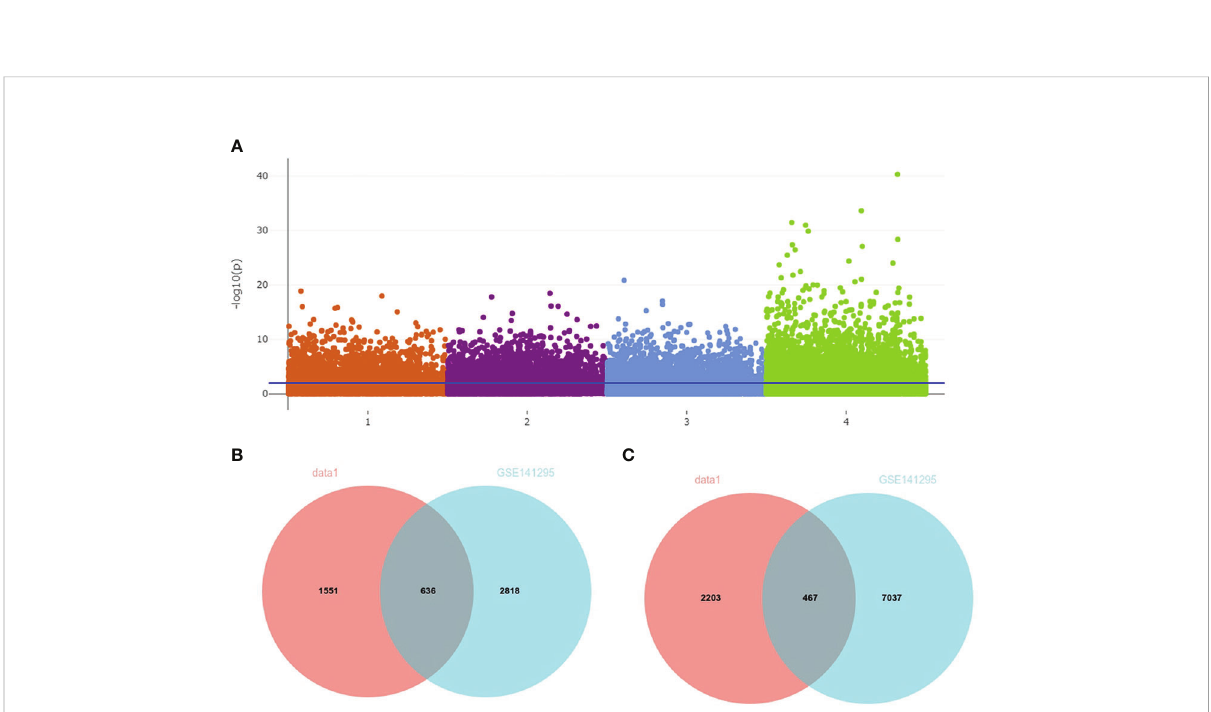
FIGURE 4 Identi fi cation of common DEGs in data1 and GSE141295. (A) The Manhattan plot of DEGs in data1 and GSE141295. 1: 1,553 upregulated genes in the IgAN samples of data1; 2: 2,203 downregulated genes in the IgAN samples of data1; 3: 2,818 upregulated in the IgAN samples of GSE141295; 4: 7,097 downregulated in the IgAN samples of GSE141295. (B) The Venn diagram of 636 common upregulated genes in data1 and GSE141295. (C) The Venn diagram of 467 common downregulated genes in data1 and GSE141295.